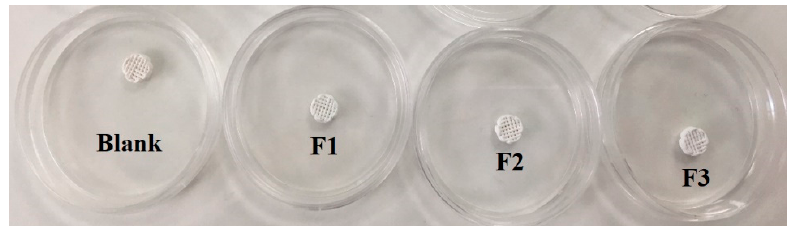
Figure 2. Uncoated/blank and F1–F3 coated scaffolds. Figure 2. Uncoated / blank and F1–F3 coated sca ff